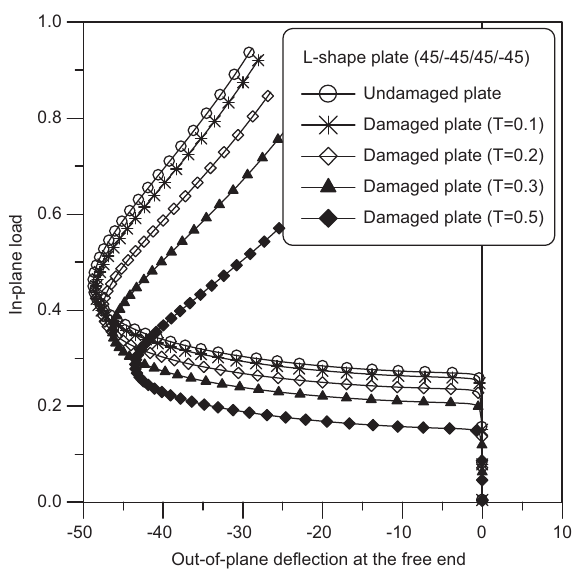
Figure 6 Tip defl ection at the free end of the L-shaped laminated composite plate.